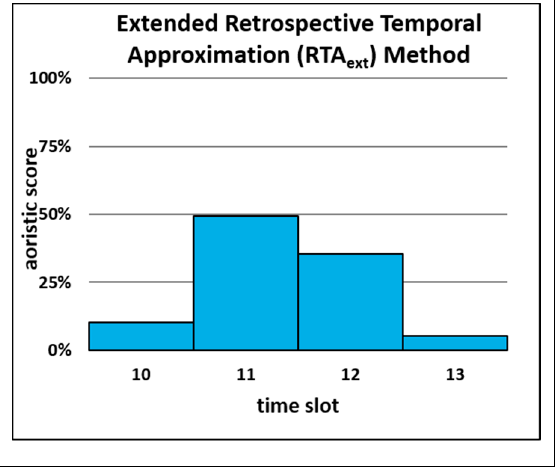
Figure 3. An example of the results of the extended retrospective temporal approximation (RTA ext )